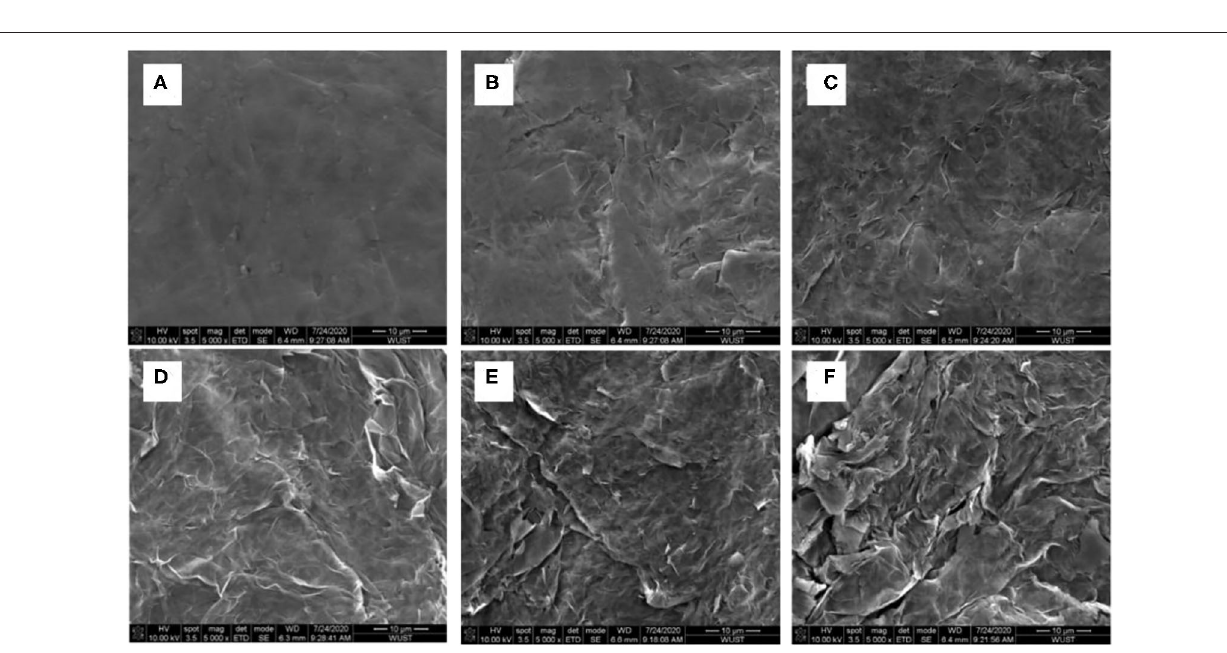
et al., 2019). Moreover, through comparing the half peak width the cell with non-activated graphite paper (NAGP), the observed anodic peak in all cells with AGP migrates more negatively, and anodic current density, the anodic peak located at 1.62 V which could be related to the electrode activation effects, similar shows the narrowest and highest, which implies a faster kinetic to the observation of the initial profile changes in MnO 2 -based process on S3 interface than on the others’. In cathodic scan, a cathodes in ZIBs (Zhang et al., 2016). Further comparison finds large cathodic peak centered at 1.29 and 1.34 V for S1 and S2, that during the anodic sweeping, peaks centered at 1.55 and respectively, is converted into two distinctive peaks as captured in 1.50 V for S1 and S2, respectively, become sharp at 1.62, 1.67, CV of S3, S4, and S5. Enlightened by the phenomenon observed and 1.7 V in CV of S3, S4, and S5 separately. The change is in LiMn 2 O 4 , that two distinct cathodic peaks correspond to a suspected to be induced by anions (SO 2 − ) intercalation into two-step insertion of Li + into a Li-rich and Li-depleted state (Lu 4 et al., 2014; Suo et al., 2015), these two distinct cathodic graphite interlayers as discussed in zinc graphite battery (Fan